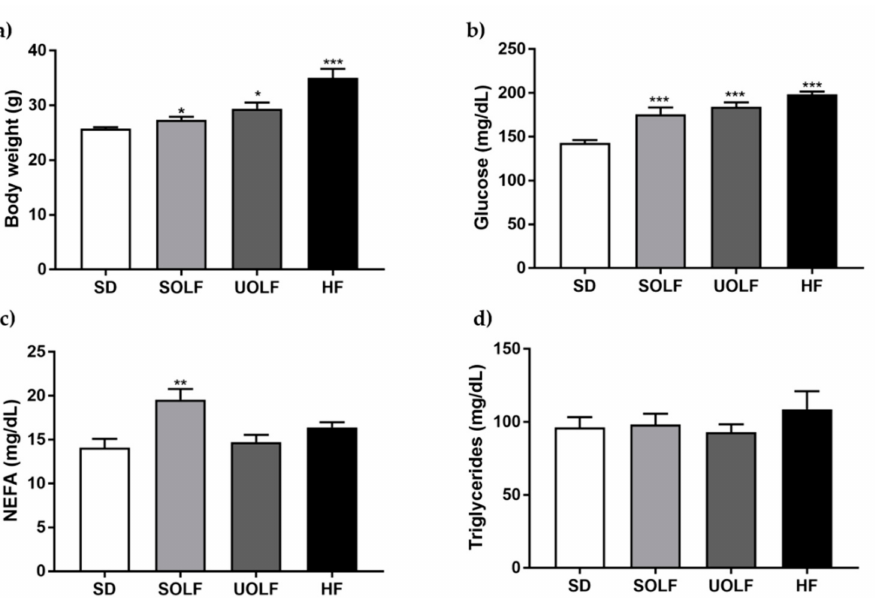
Figure 1. Body weight and biochemical parameters. Bar graphs showing body weight ( a ) and plasmatic concentrations of glucose ( b ), non-esterified free-fatty acids (NEFA); ( c ) and triglycerides ( d ). Data are shown as mean ± SEM of 7–10 animals per strain. * p < 0.05, ** p < 0.01, *** p < 0.001 vs. the control group